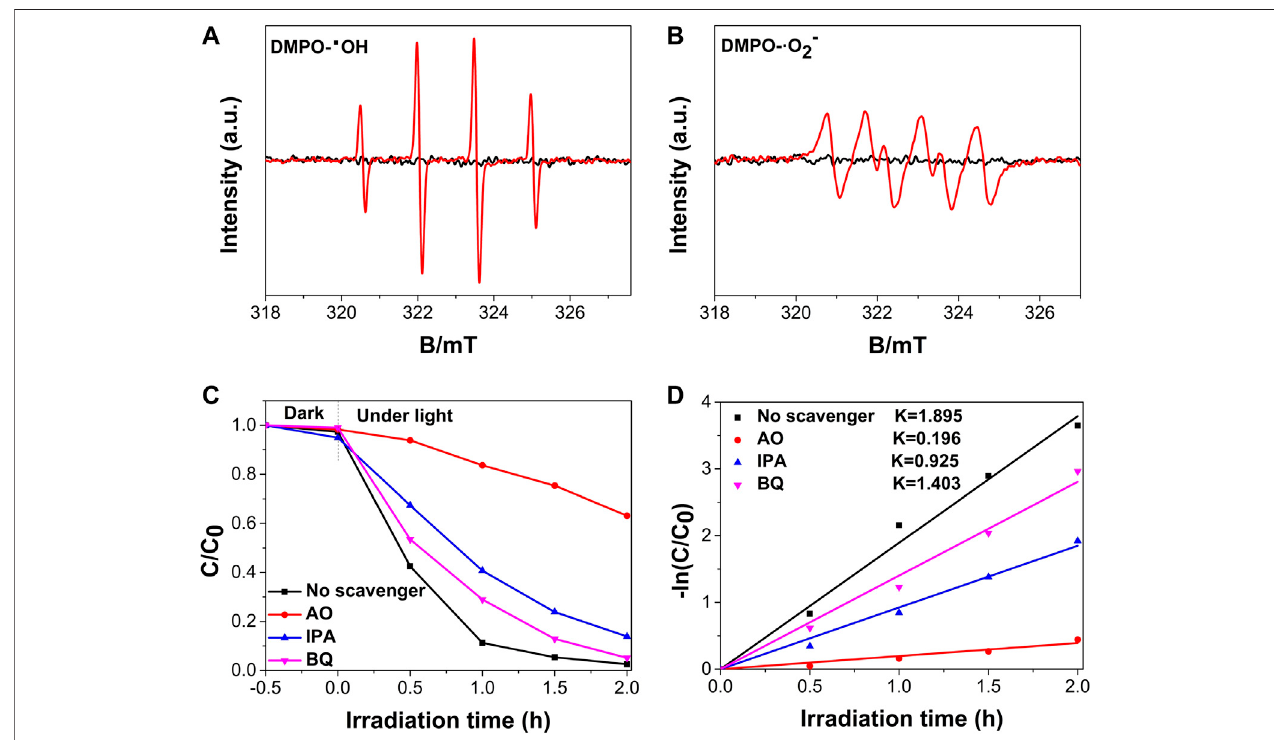
FIGURE 8 | DMPO ESR and ROSs trapping experiments of the N,Cu-CDs/m-WO 3 -0.8 nanocomposite: DMPO- · OH (A) ; DMPO- · O2- (B) ; ROSs trapping experiments (C) ; and kinetic fi t for ROSs trapping experiments (D) .